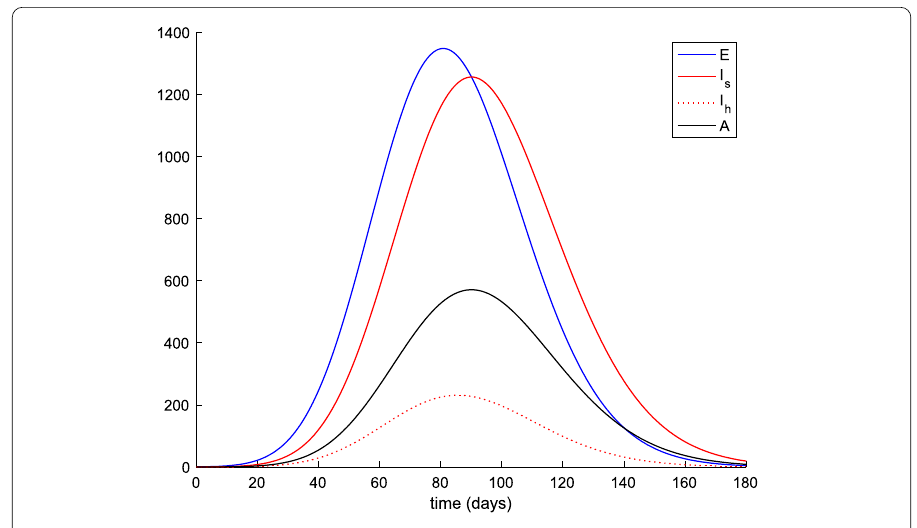
Figure 13 Evolution of exposed, infectious (slight and hospitalized), and asymptomatic when vaccination and treatment are applied with k V = 0.001 and k T = 0.004